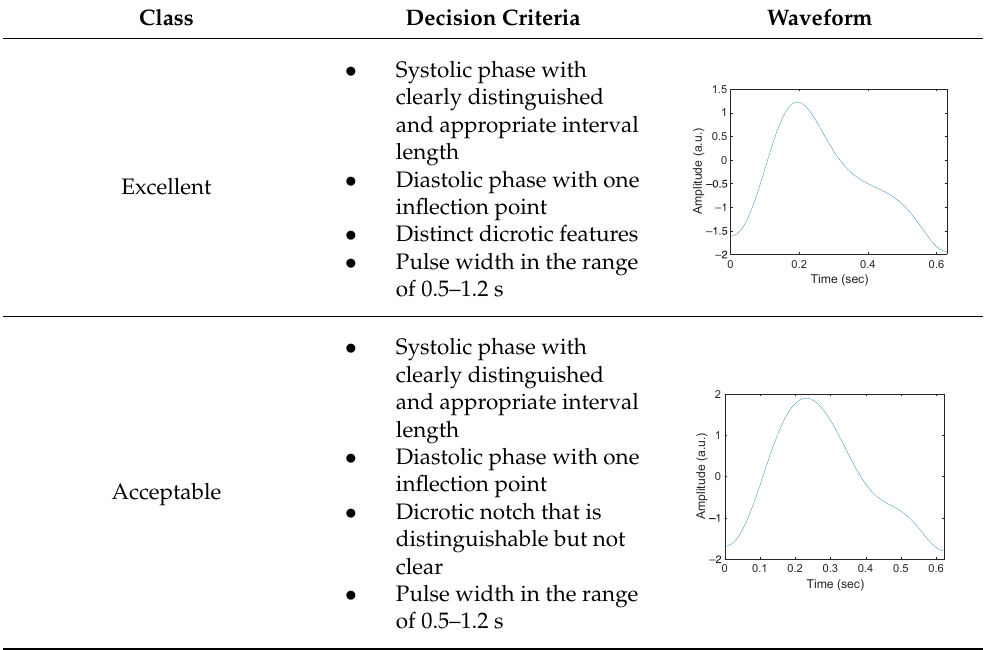
Table 1. Category, decision criteria, and waveform example for pulse quality labeling.